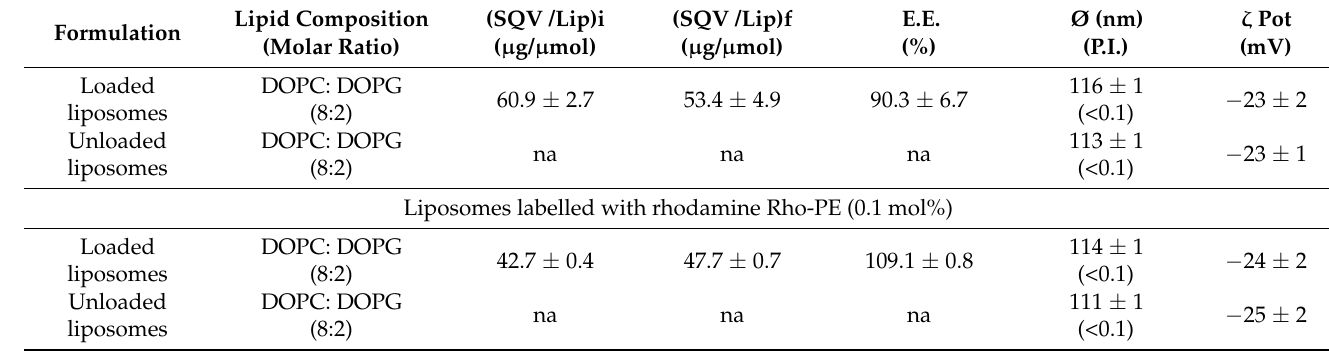
Table 1. Physicochemical characterization of liposomes unloaded or incorporating